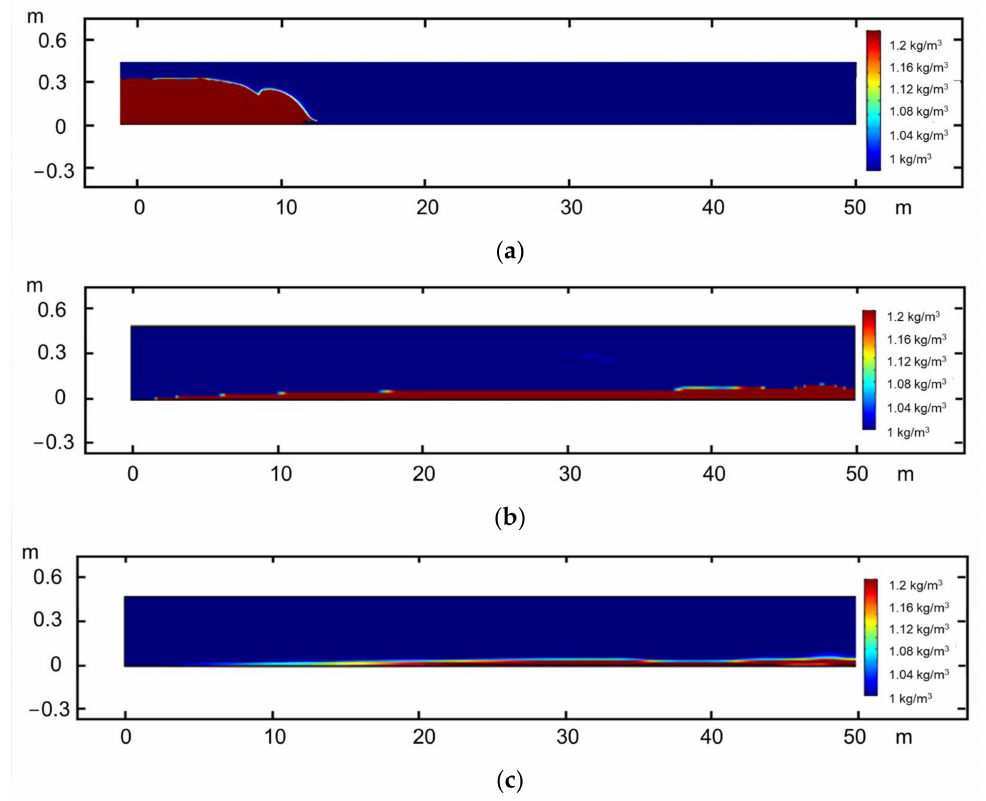
Figure 24. Simulation results of proppant transport capacity in near-real-size fractures. (( a ) is the simulation result of the migration capability of the quartz sand proppants at a viscosity of 1 mPa · s; ( b , c ) are the simulation result of the migration capability of the emulsion phase change proppant at the viscosity of 1 mPa · s and 15 mPa ·